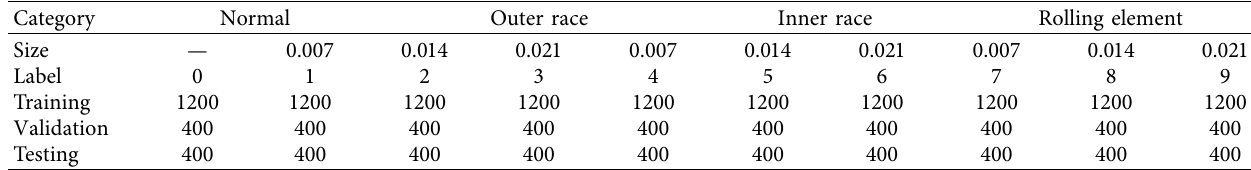
Table 2: Samples in the CWRU dataset.